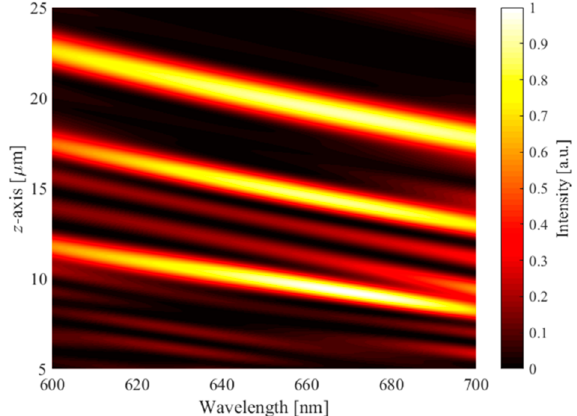
Figure 5. Numerical simulation of the monochromatic multi-focal MFZP specified in Table 1, regarding the normalized intensity distribution along the z -axis with respect to incident wavelength.